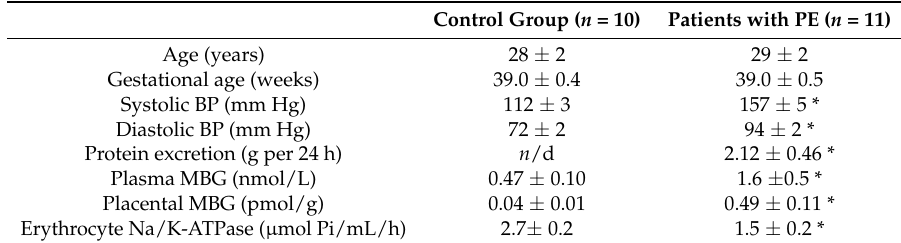
Table 1. Characteristics of the study